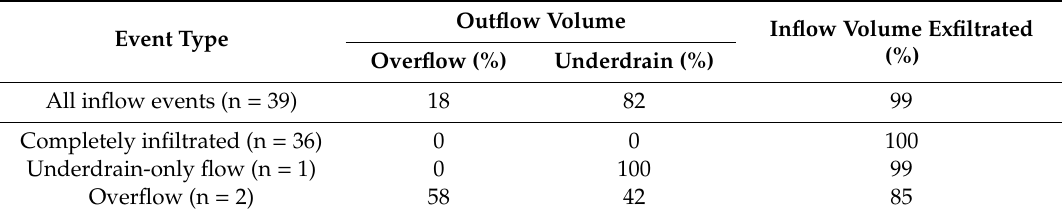
Table 5. Mean fate of inflow volume and outlet volume of the 39 events.